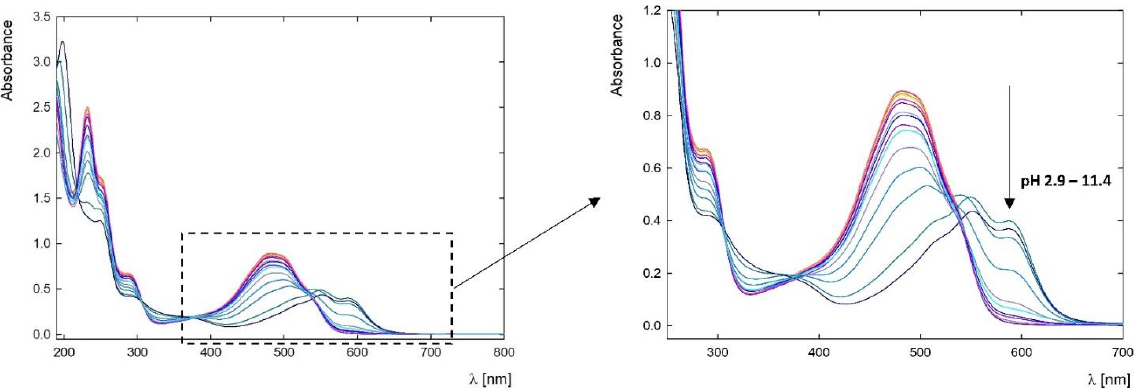
Figure 2. UV-Vis spectra of doxorubicin depend on the pH of the solution, with a concentration of c = 50 ppm in water in the pH range of 2.9 – 11.4. c = 50 ppm in water in the pH range of